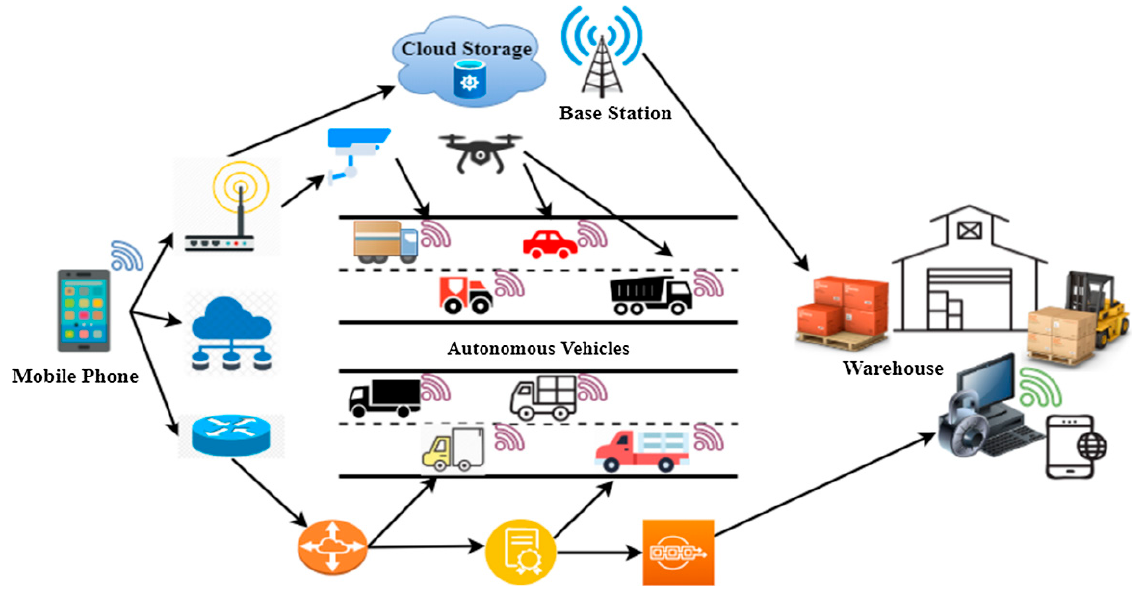
Figure 1. IoT-assisted intelligent logistics transportation management framework